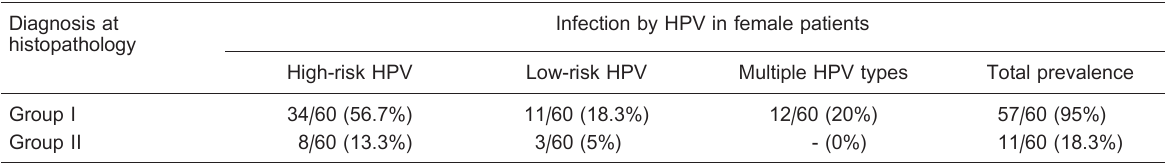
Table 1. Frequency of HPV DNA detection by PCR in female patients from groups I (CIN) and II (asymptomatic) according to histological diagnosis. Diagnosis at